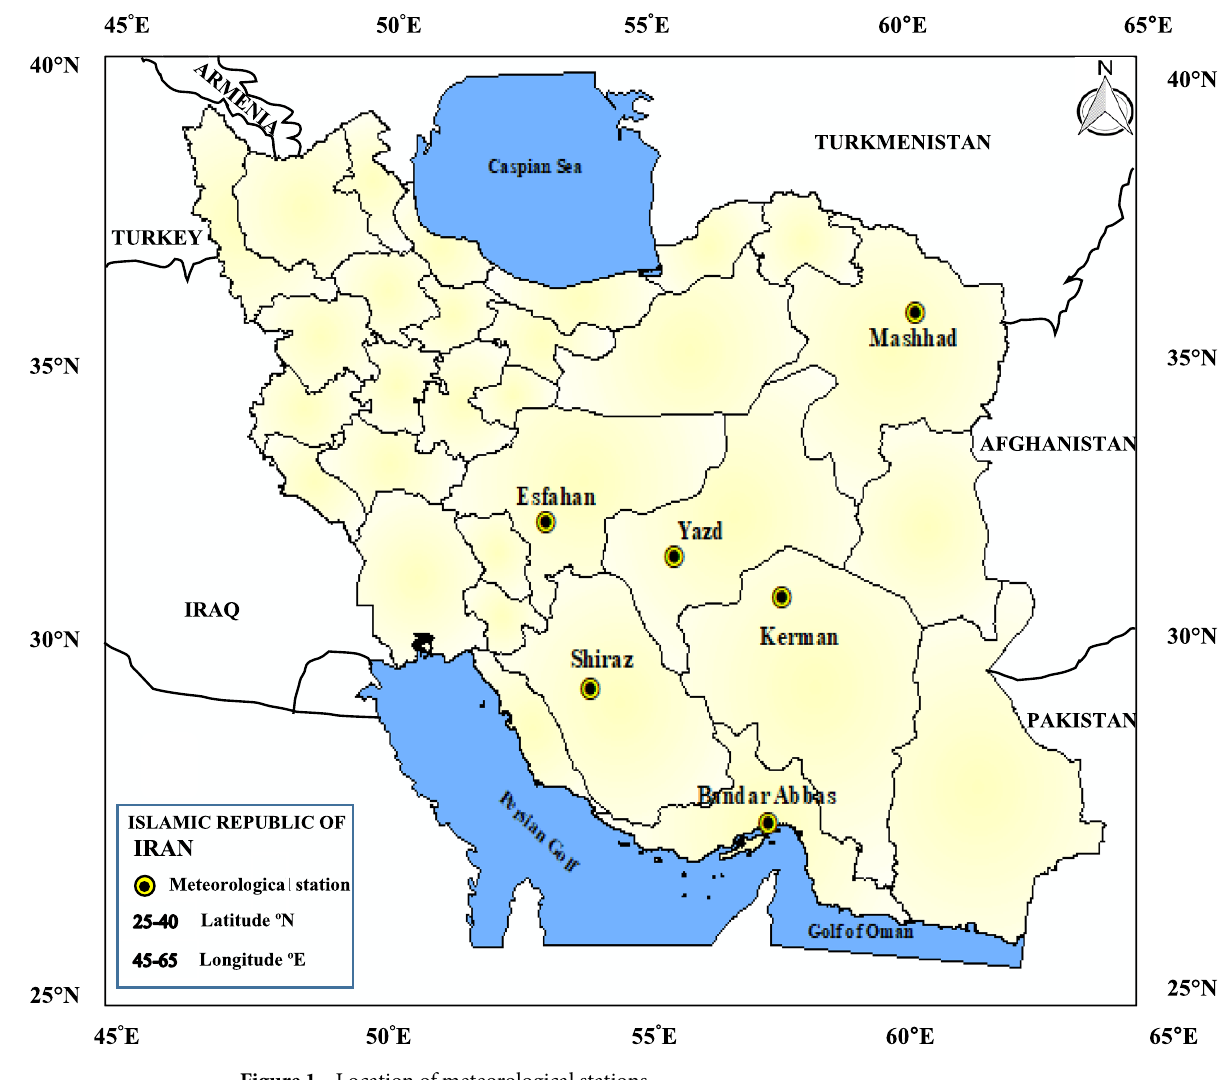
Figure 1. Location of meteorological stations.